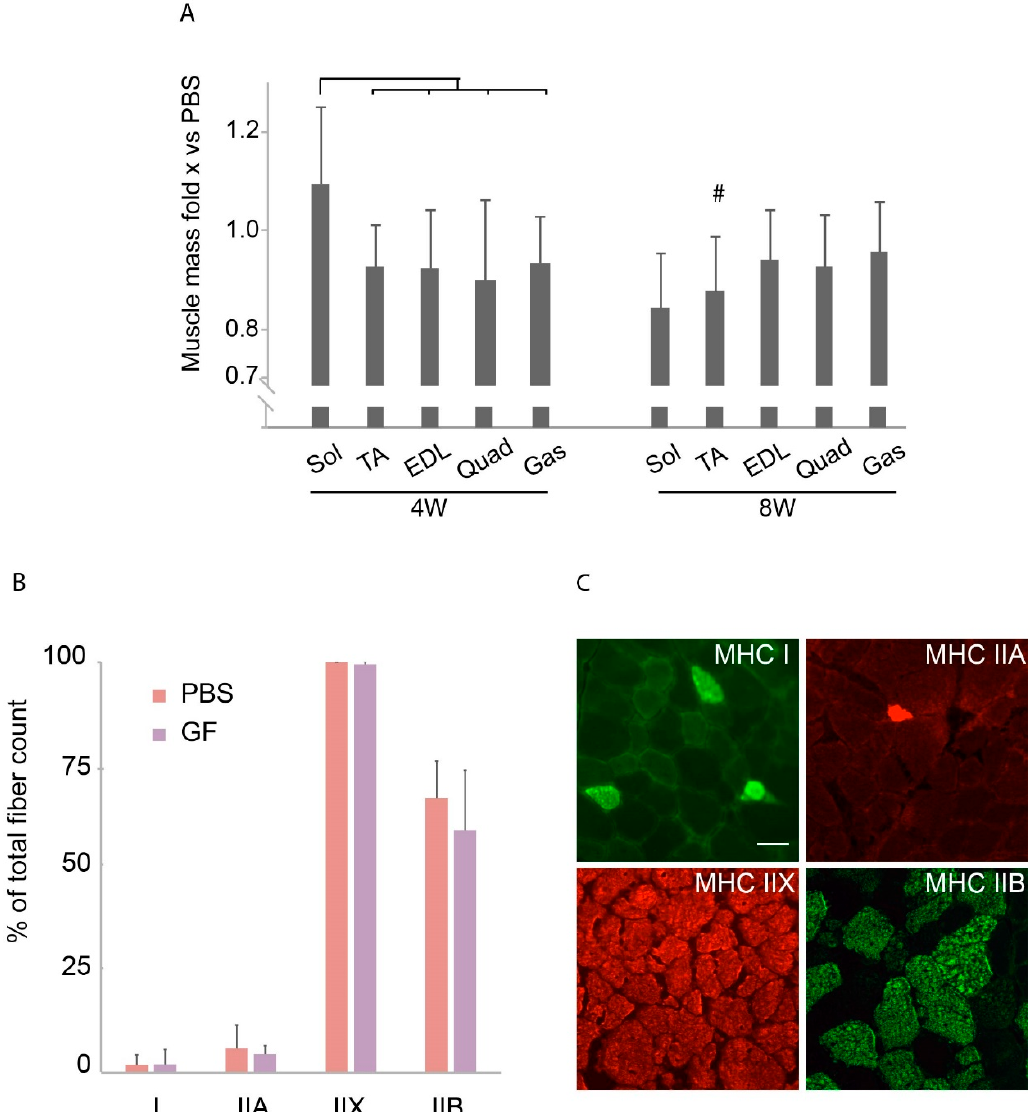
Figure 4 . Muscle mass of treatment groups in relation to PBS and fiber-type composition. ( A ) Muscle mass of various muscles treated with growth factors compared to PBS in the two age-groups. N = 11 for 4W group, N = 9 for 8W group. ( B ) Percentage of each fiber-type present in TA in treated ( N = 7) versus untreated ( N = 6) 8W mice. The total distribution exceeded 100% since mixed fibers were counted twice. ( C ) Representative stains of fiber-types MHC I, IIA, IIX, and IIB. Bar represent 50 µ m. EDL, m. extensor digitorum longus; Gas, m. gastrocnemius; PBS, phosphate-buffered saline; Quad, m. quadriceps; Sol, m. soleus; TA, m. tibialis anterior. Data presented as mean and vertical bars representing SD. Two-way ANOVAs were performed with subsequent Tukey HSD post-hoc tests to assess significance. Bars: p < 0.05, #: p < 0.05 vs.